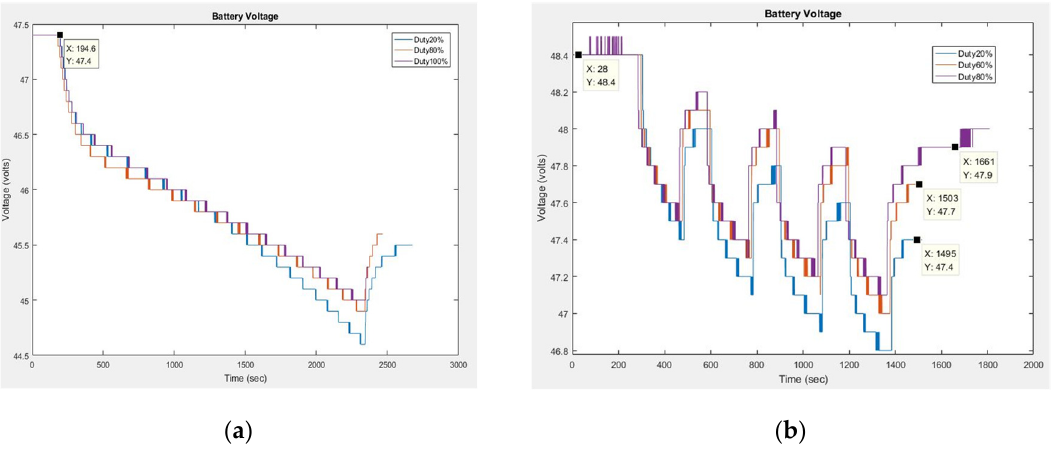
Figure 5. ( a ) Voltage drop vs. duty ratio in constant-current discharge: ( b ) voltage drop vs. duty ratio in pulse discharge.